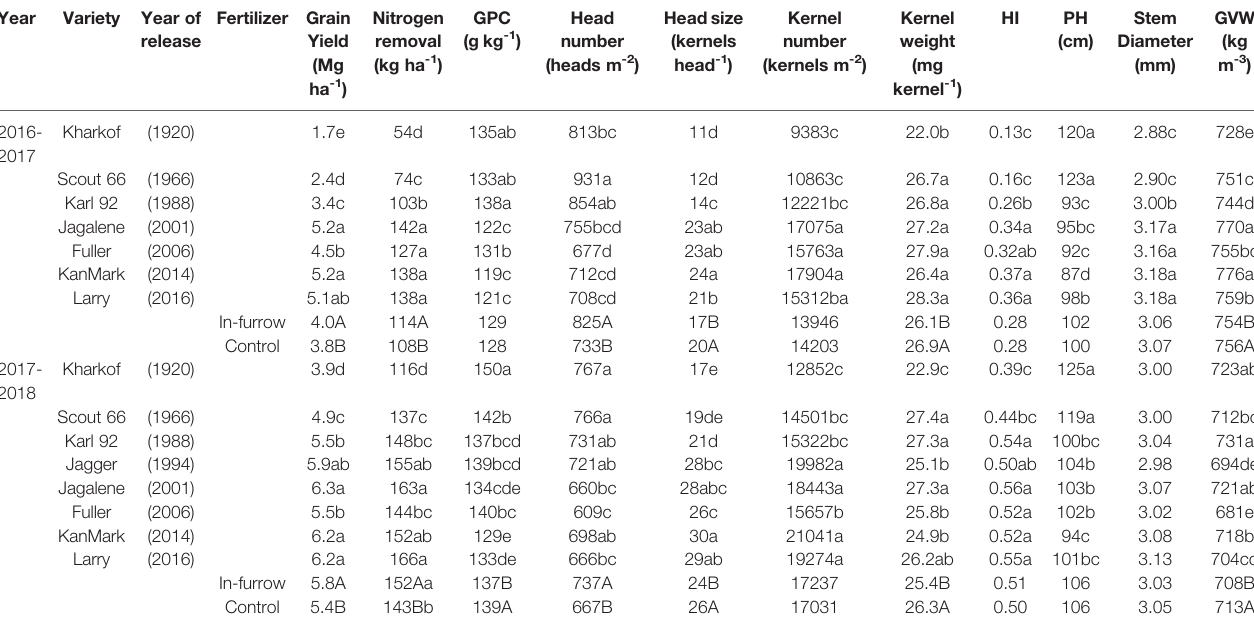
TABLE 3 | Grain yield, head number, head size, kernel number, kernel weight, harvest index (HI), plant height (PH), stem diameter, grain protein concentration (GPC) and grain volume weight (GVW) of wheat varieties released between 1920 and 2016, fertilizer treatment, and their interaction during the growing seasons